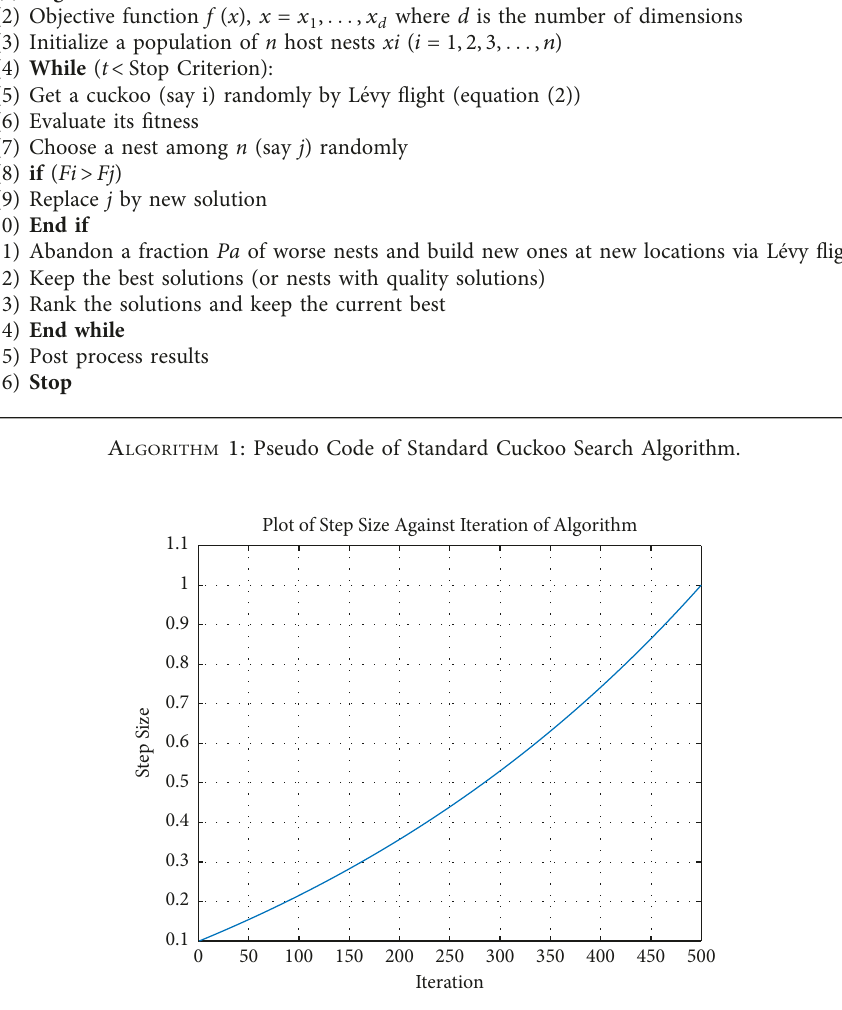
Figure 1: Plot showing the step size of the algorithm against the increasing number of iterations. Plot of Probability of Discovery Against Iteration of Algorithm